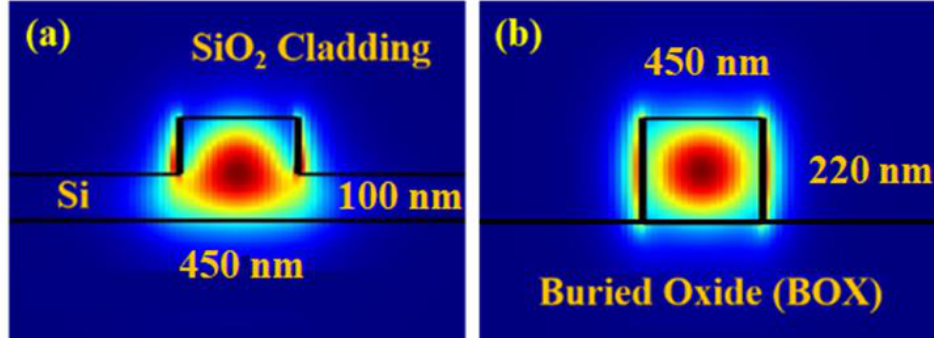
Figure 1. Schematic and transverse electric (TE) mode profiles for a ( a ) single mode rib waveguide, and ( b ) single mode strip waveguide, at λ = 1.55 µm. The Si thickness is 220 nm in both cases, with the slab thickness equal to 100 nm for the rib waveguide. Waveguide width = 450 nm. Note that the x -axis and y -axis scales are not equivalent.